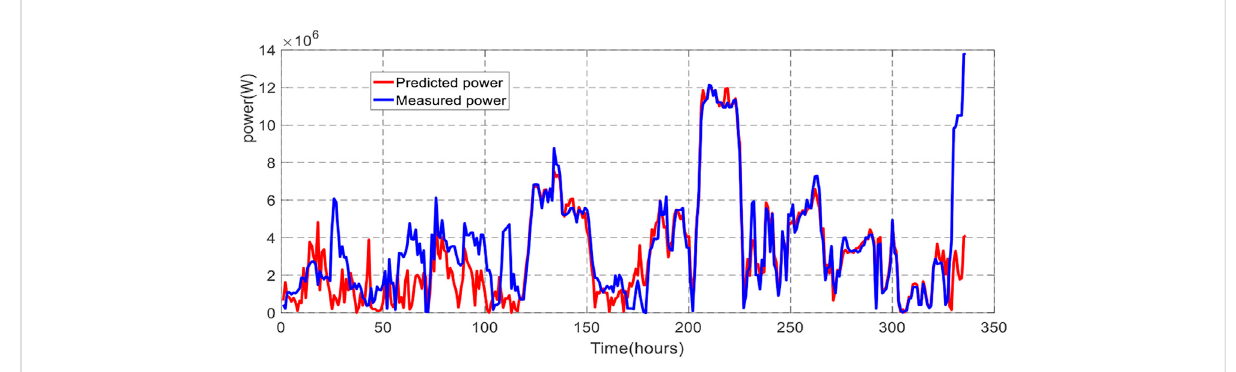
FIGURE 15 Wind power forecasting (7 days).